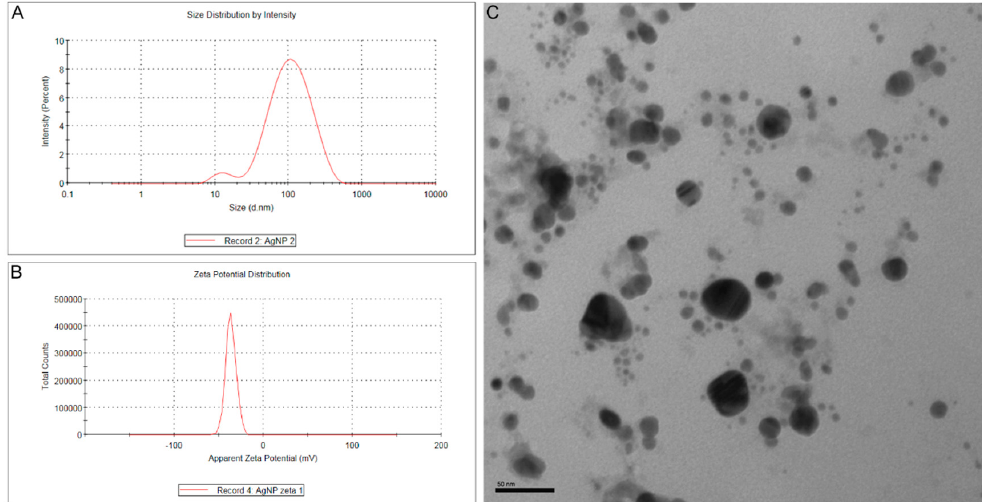
Figure 1. ( A ) Size distribution by intensity (%) of bio-AgNPs produced with Fusarium oxysporum components. The mean diameter of bio-AgNPs was 81.25 nm with a polydispersity index (PDI) value of 0.296. ( B ) Apparent zeta potential distribution by total counts of bio-AgNPs produced with Fusarium oxysporum components. The mean zeta potential of bio-AgNPs was − 36.4 mV. ( C ) Trans- mission electron micrograph of bio-AgNPs. Spherical nanoparticles were observed in this micro- graph (200,000×).